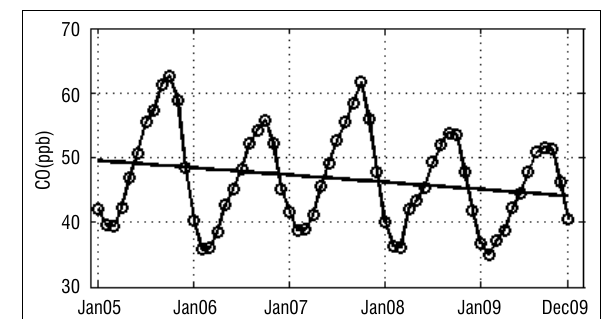
Figure 10: Cape Point Global Atmosphere Watch station monthly means (from January 2005 to December 2009) with linear trend